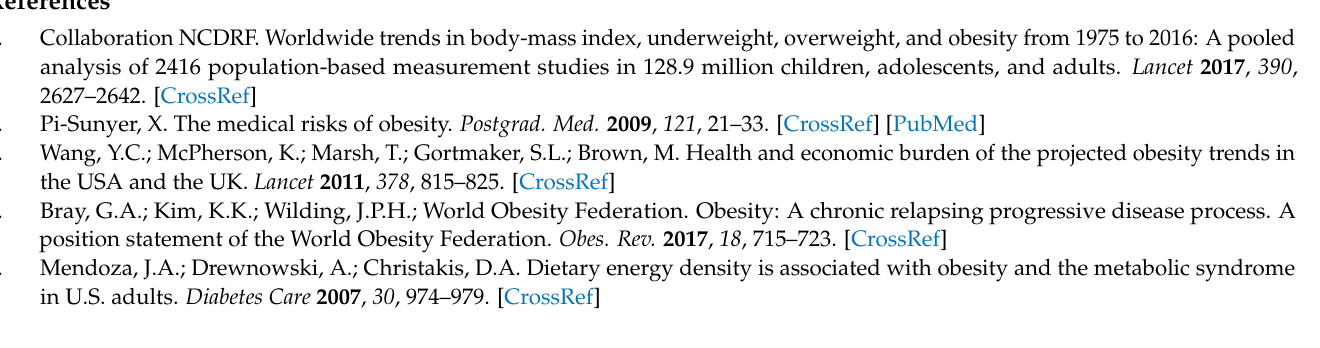
Figure A2. ( a – f ) Mean scores for the gastrointestinal response of the participants for the three conditions at baseline and during 3-week consumption period.